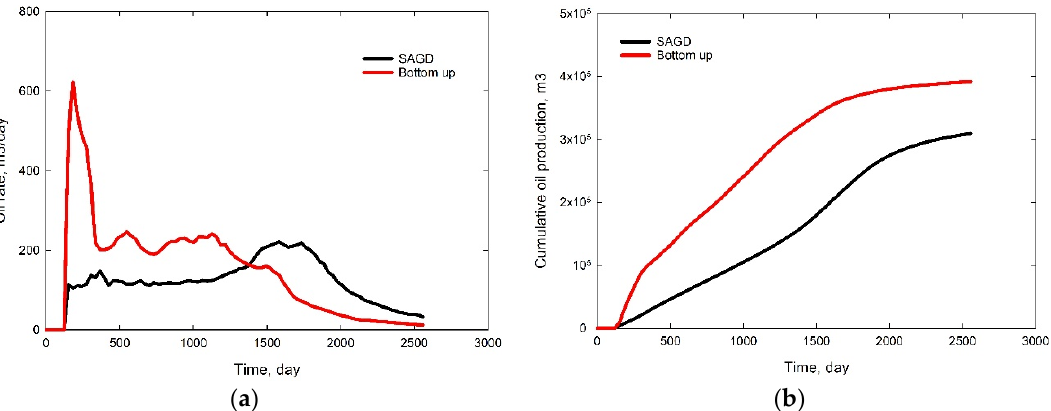
Figure 5. Comparison of ( a ) oil production rate and ( b ) cumulative oil production between bottom ‐ up assisted pressure drive and SAGD processes indicating that bottom ‐ up assisted pressure drive improves oil production.